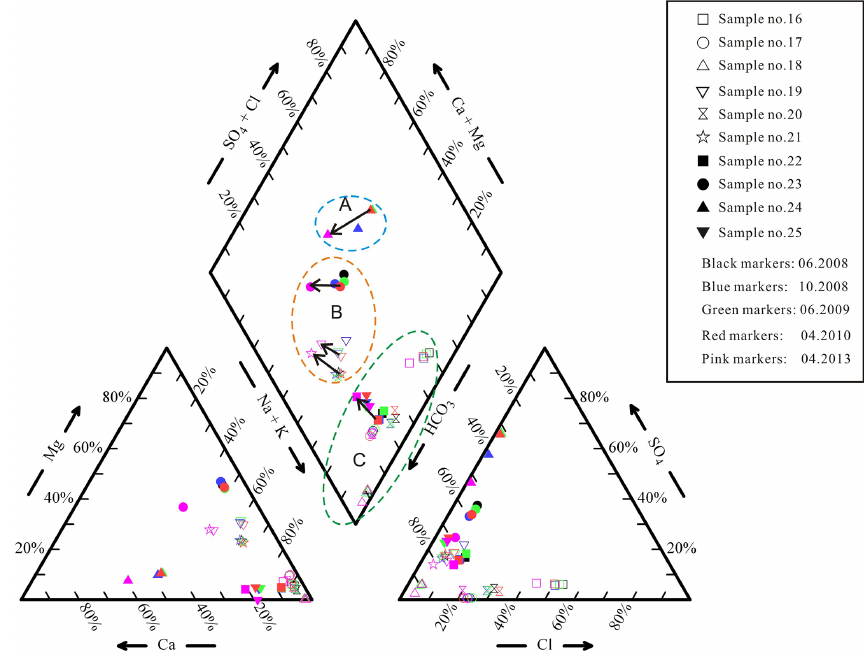
Figure 2. Piper diagram of the spring water